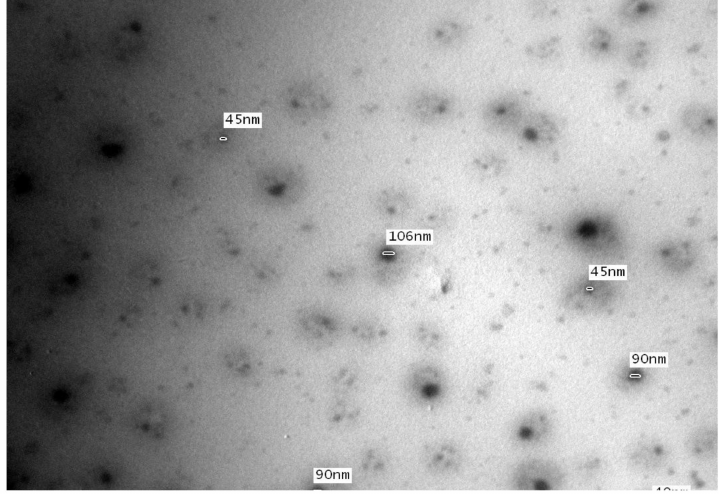
Figure 2. Transmission electron microscope (TEM) image of S. satureioides oil